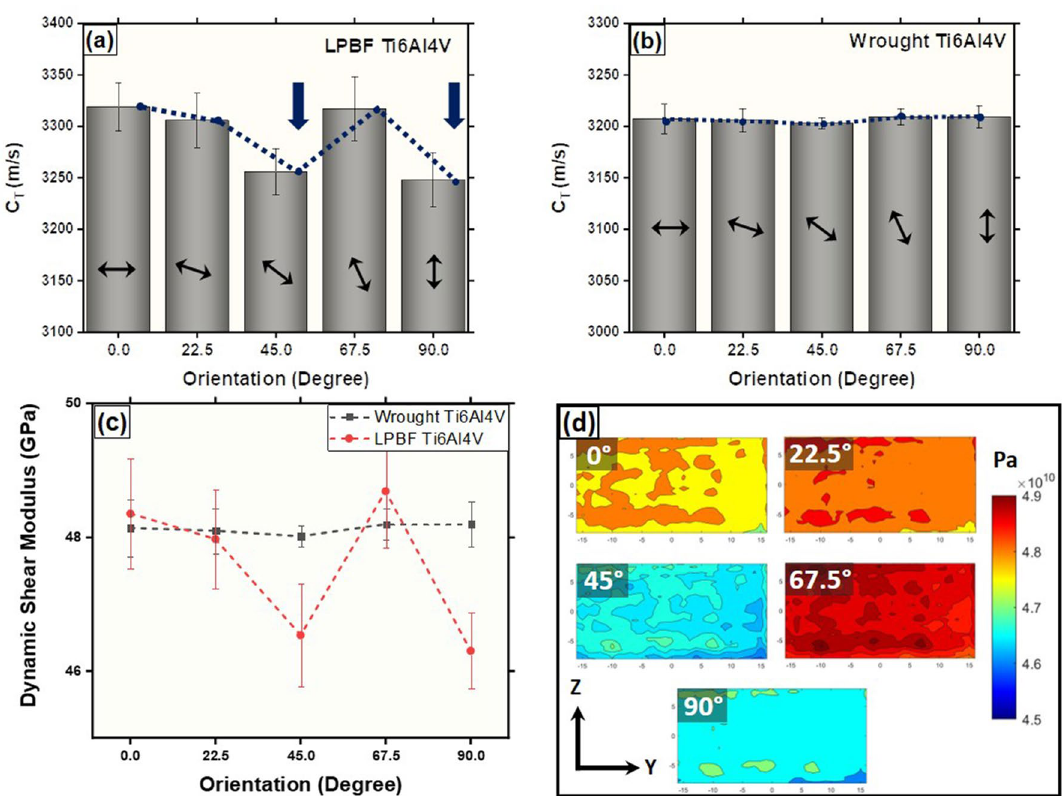
Figure 2. Variation in velocity of shear waves as a function of shear wave plane orientation with respect to build plane normal for ( a ) LPBF-AM Ti6Al4V and ( b ) wrought reference Ti6Al4V sample and ( c ) corresponding shear modulii of wrought and LPBF-AM Ti6Al4V. ( d ) Shear modulus contour maps on YZ plane of LPBF-AM Ti6Al4V cube at different shear wave plane